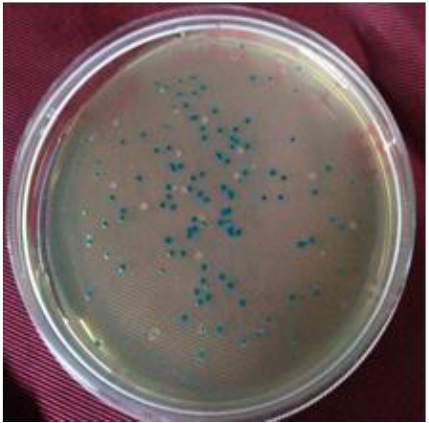
Figure 7. Blue – white screening of recombinant clones representing subgenomic library of Swarnaprabha by α -complementation. White colonies are recombinant clones containing subgenomic DNA of rice. Blue colonies are non-recombinant vector molecules (self-ligated pBluescript DNA).